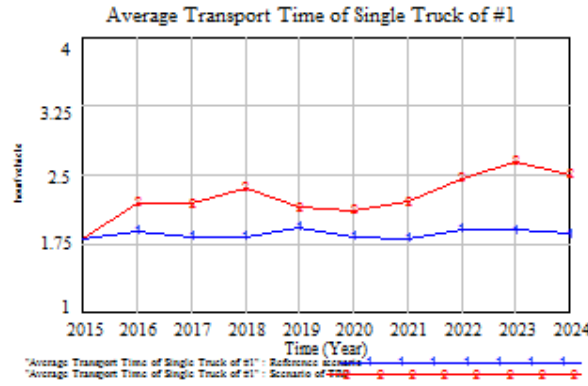
Figure 5. TRP effects on the average transport time of a single truck using the express highway